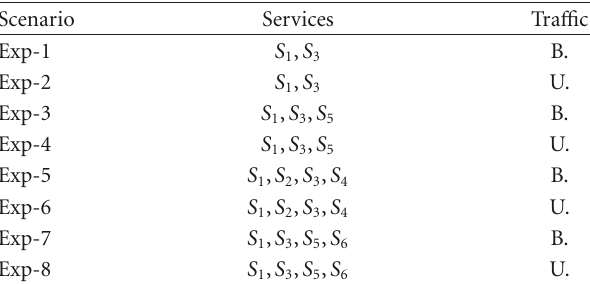
Figure 5: Comparison of the cell radius obtained by the di ff erent heuristics considered in all scenarios. Table 5: Experiments definition.